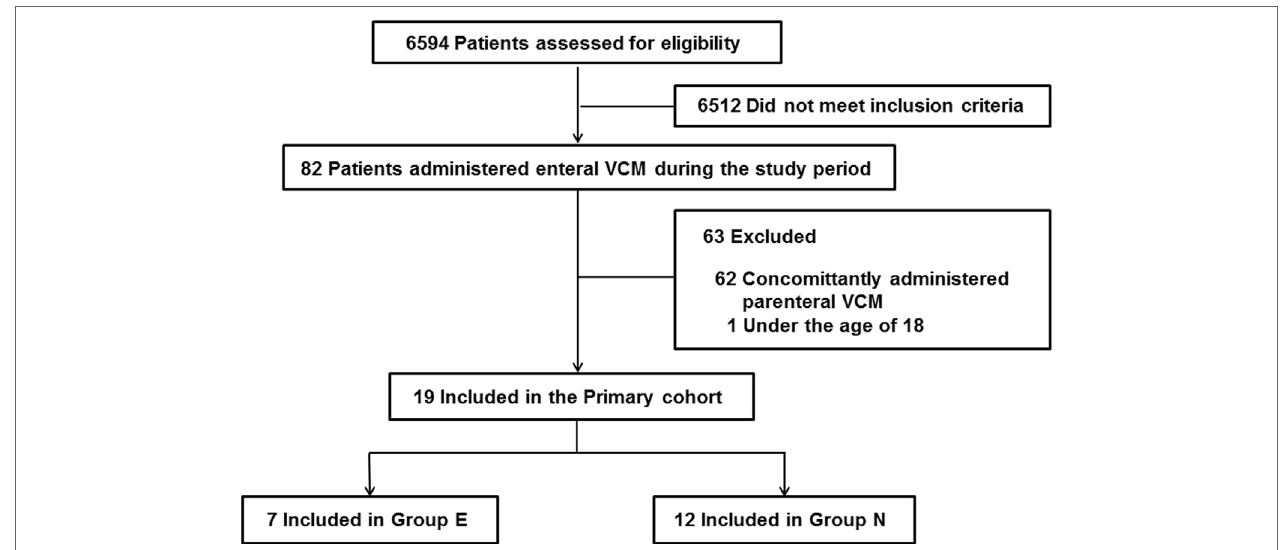
FigUre 1 | The flowchart of the study